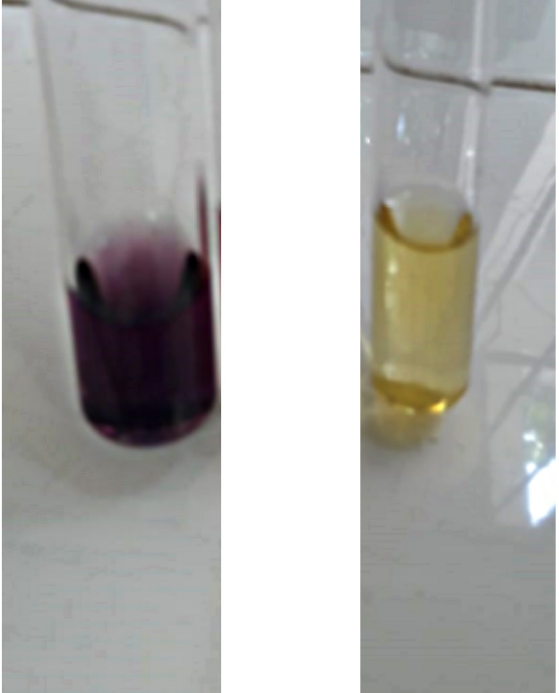
Figure 2. Antioxidant assay by DPPH (Negative control (left): DPPH + methanol; Positive control (right): DPPH + ascorbic